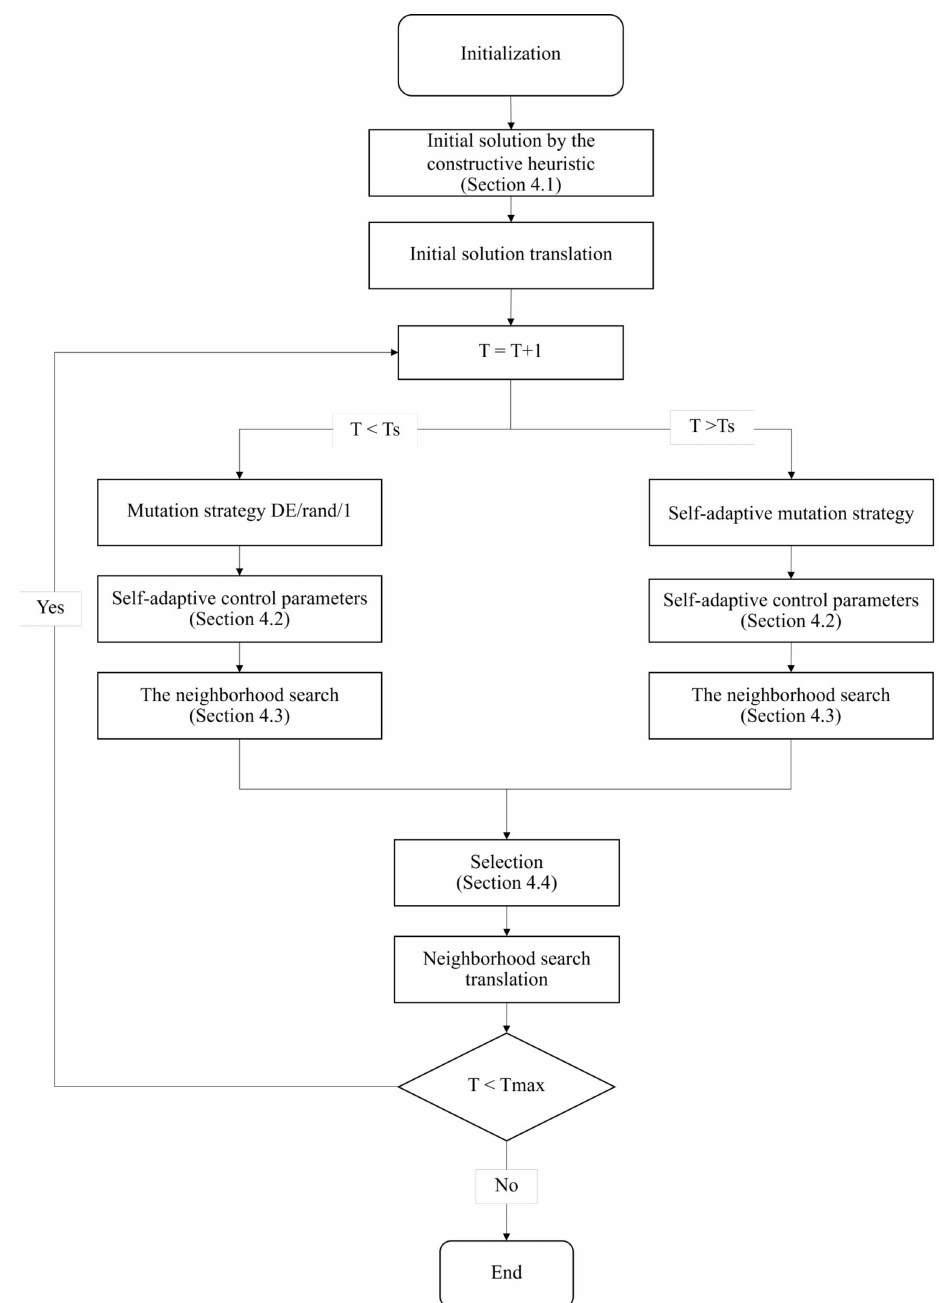
Figure 3. Framework of the HSADE